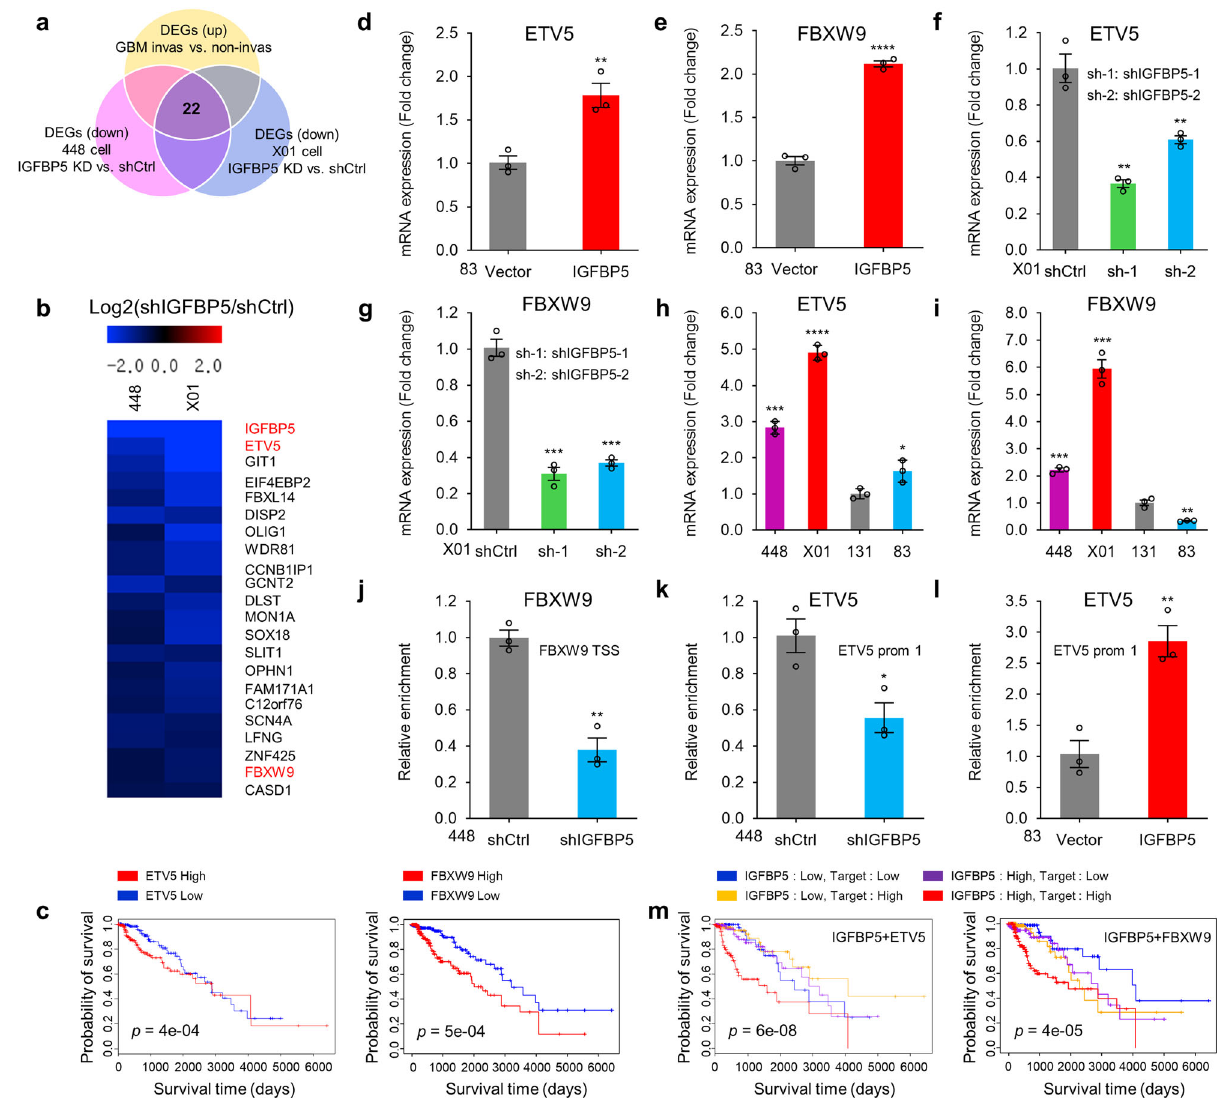
*** P =0.0002). h,i RT-qPCRanalysisofETV5andFBXW9expressionininvasiveGSCs (X01 and 448) and non-invasive GSCs (131 and 83). Data are presented as mean± SEM( n =3independentexperiments),two-tailedStudent ’ s t -test(comparewith131 group, left to right, *** P =0.0002, **** P =0.00001, * P =0.03; *** P =0.0006, *** P =0.0001, ** P =0.003). j ChIP-qPCRanalysisofCREBbindingtothe FBXW9 TSSin 448 GSCs infected with shCtrl or shIGFBP5-1 lentivirus. Data are presented as mean±SEM ( n =3 independent experiments), two-tailed Student ’ s t -test ( ** P =0.002). k, l ChIP-qPCR analysis of CREB binding to the ETV5 promoter in 448 GSCs infected with shCtrl or shIGFBP5-1 lentivirus or in 83 GSCs infected with vector control or IGFBP5 lentivirus. Data are presented as mean±SEM ( n =3 independent experiments), two-tailed Student ’ s t -test ( k , l , * P =0.02, ** P =0.006). m Kaplan – Meier survival curves for LGG patients strati fi ed by IGFBP5 and ETV5 (left, P =0.00000006) or IGFBP5 and FBXW9 expression (right, P =0.00004),log- rank test. Source data are provided as the Source Data fi